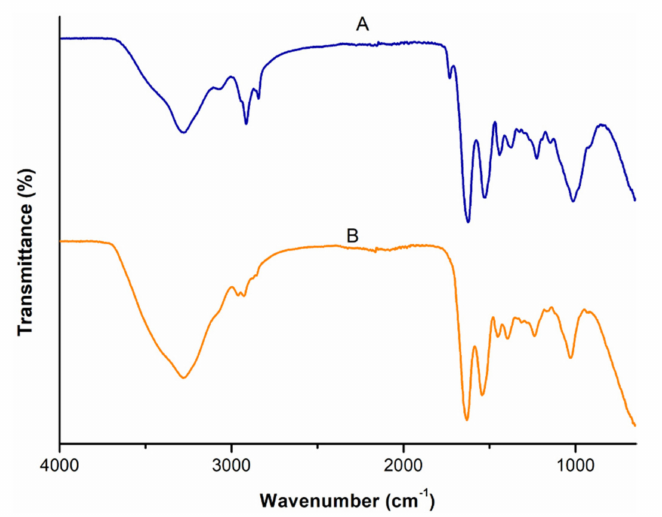
Figure 7. Changes in the FTIR spectra of the colorectal membrane recorded: (A): before permeation studies and (B): at the end of the permeation